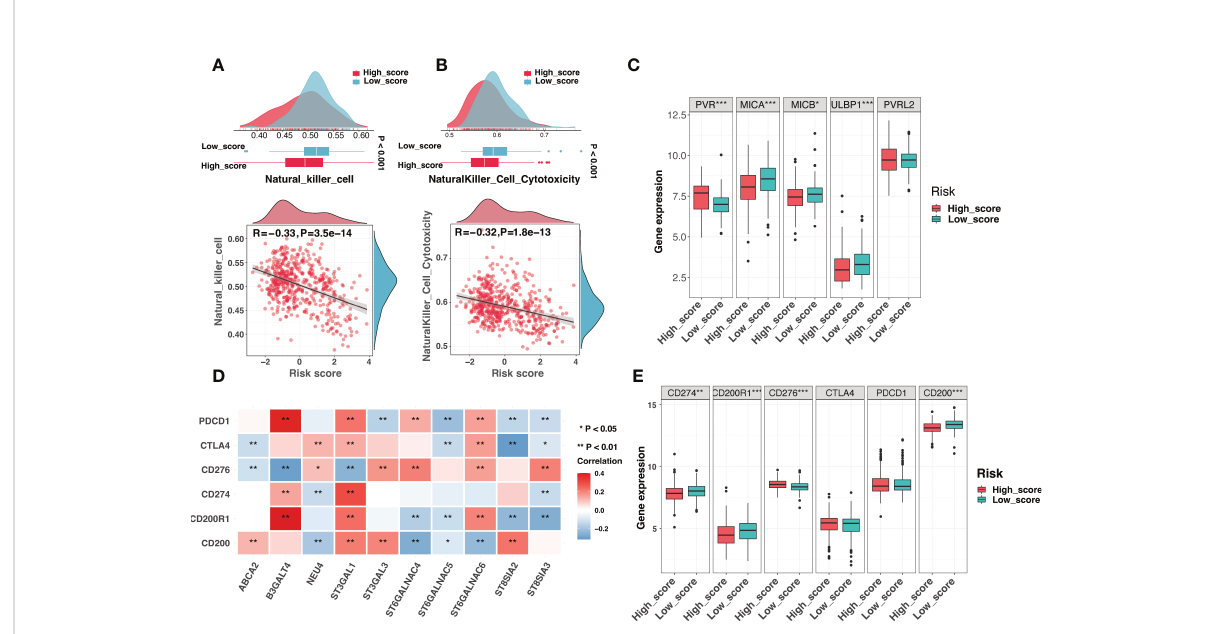
FIGURE 10 Comparison of NK cell activity and immune checkpoints in the risk signature (A) The comparison of the NK cell in fi ltration level between different risk groups (top) and correlation analysis between the risk score and the NK cell in fi ltration level (bottom). (B) The comparison of the NK cell cytotoxicity between different risk groups (top) and correlation analysis between the risk score and the NK cell cytotoxicity (bottom). (C) The boxplot exhibited different expression levels of ligands for NK cell-activating receptors between low- score and high-score groups. (D) The correlation analysis between the expression of signature genes and established immune checkpoints. (E) The boxplot demonstrated different expression levels of immune checkpoints between low-score and high-score groups. (*: P < 0.05, **: P < 0.01, ***: P <